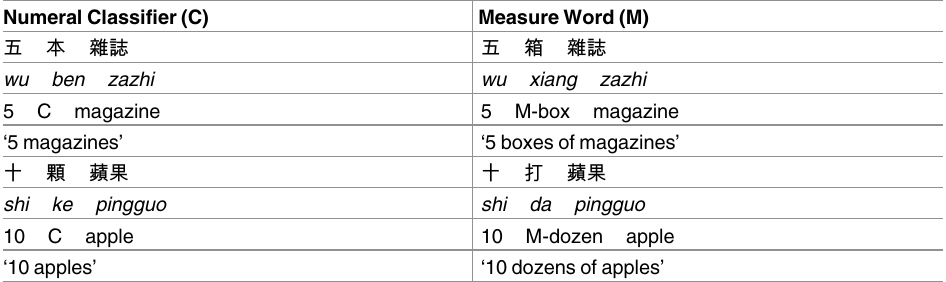
Table 1. Examples of Chinese numeral classifiers and measurewords. Numeral Classifier